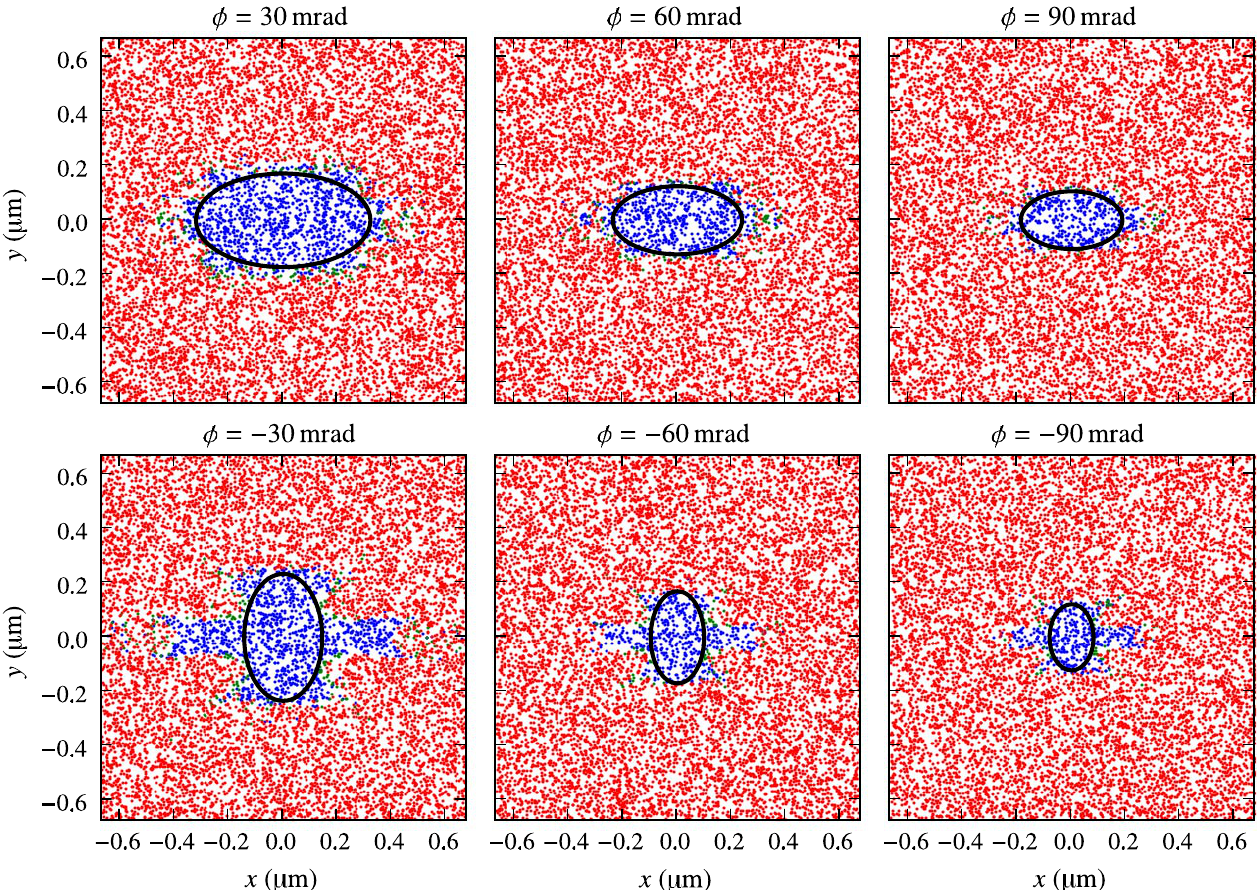
FIG. 11. Initial particle positions, with colors indicating whether, and when, each particle exited the waveguide aperture, for initial phases ranging from (cid:1) 90 to 90